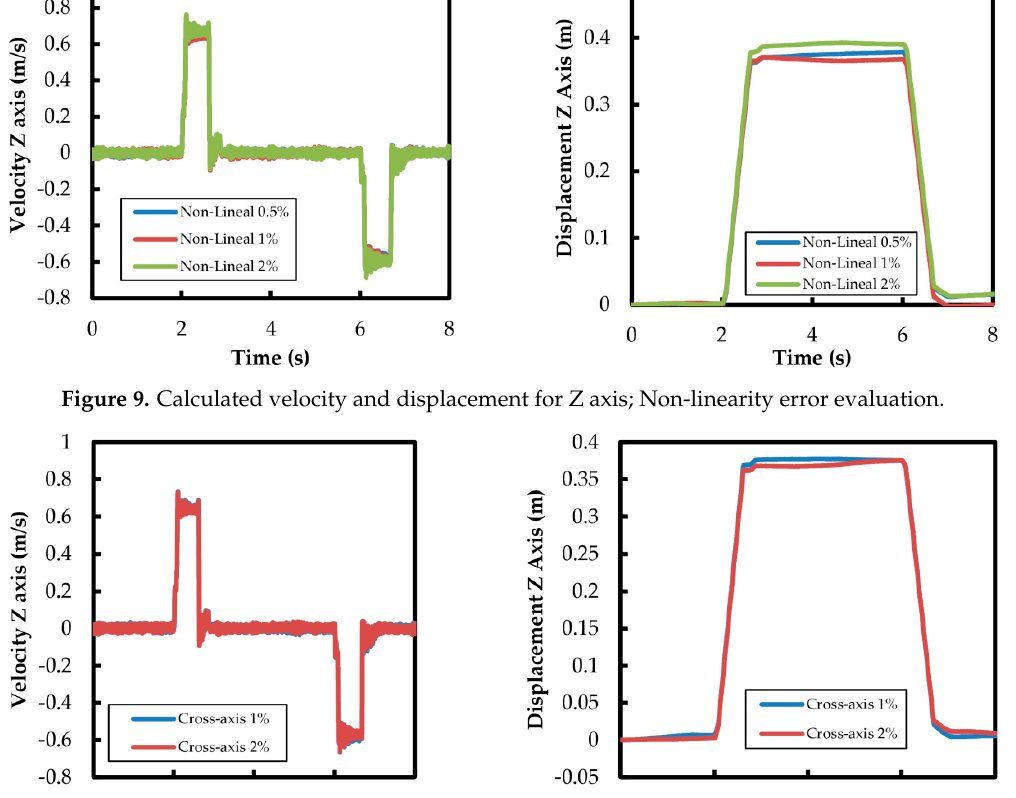
Figure 8. Calculated velocity and displacement for Z axis; Noise error evaluation.